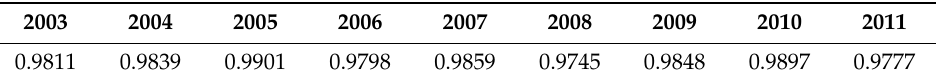
Figure 3. ( a ) Geographical distributions of difference between CF and CF R for vertical polarization at 19.4 GHz on 1 January 2004. ( b ) Scatterplot between CF and CF R for January 2004. Bin sizes are 0.01 for both axes, and statistics are provided in the scatterplot. Table 2. Correlation coefficients between directly obtained CF and modeled CF R for each